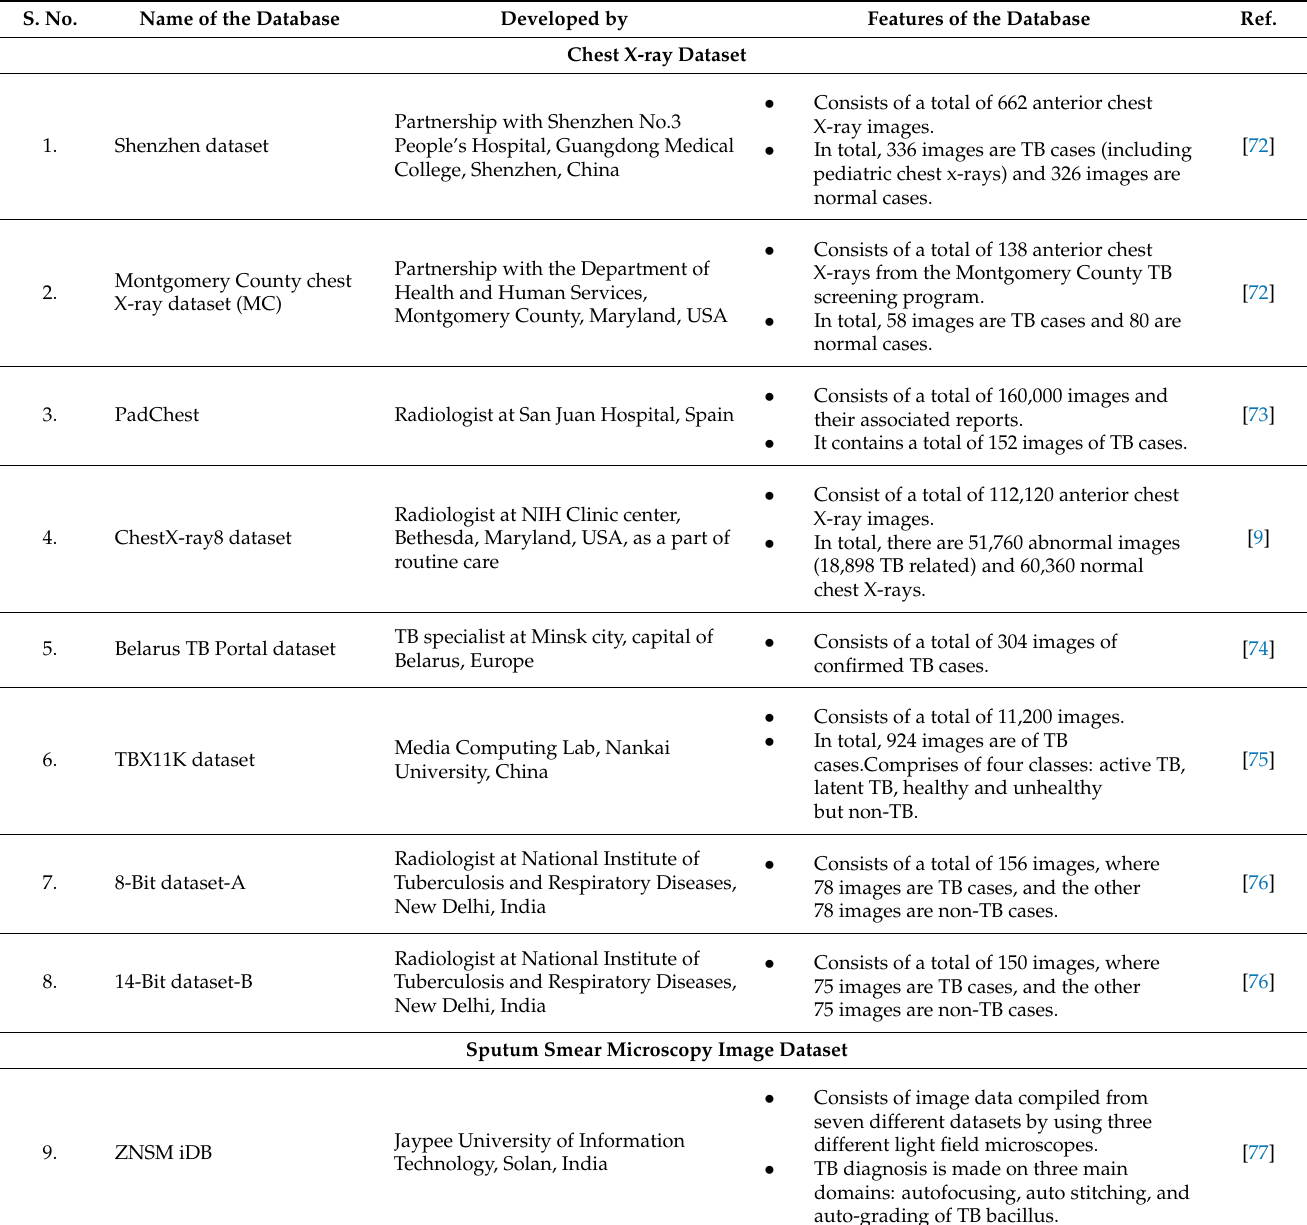
Table 3. Various datasets used in TB